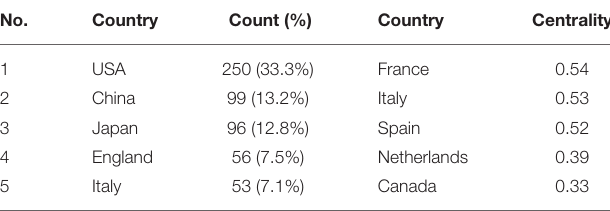
TABLE 2 | The top 10 countries/regions for publications and centrality in BHD research.